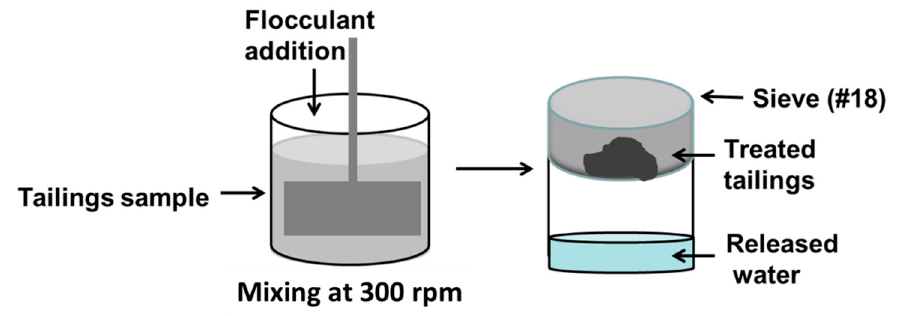
Figure 3. The process of 24 h drainage test on dewatering performance.